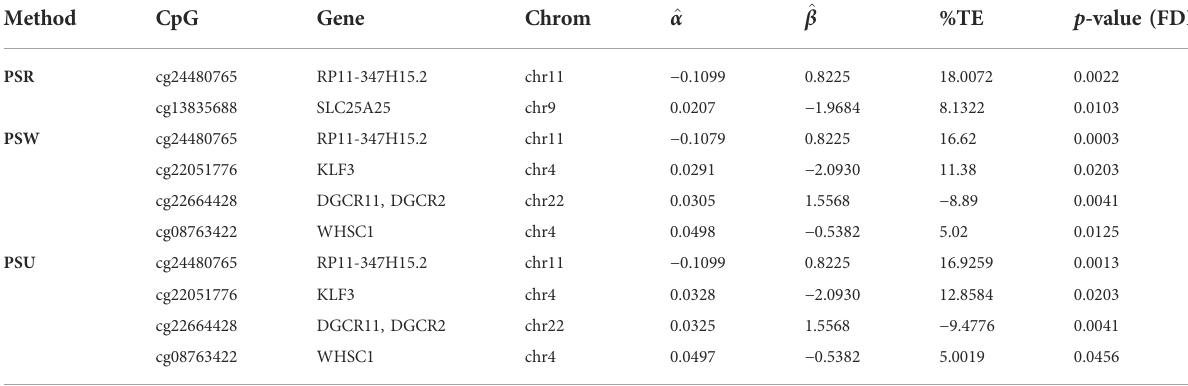
TABLE 5 Summary of the selected CpGs by the proposed models.